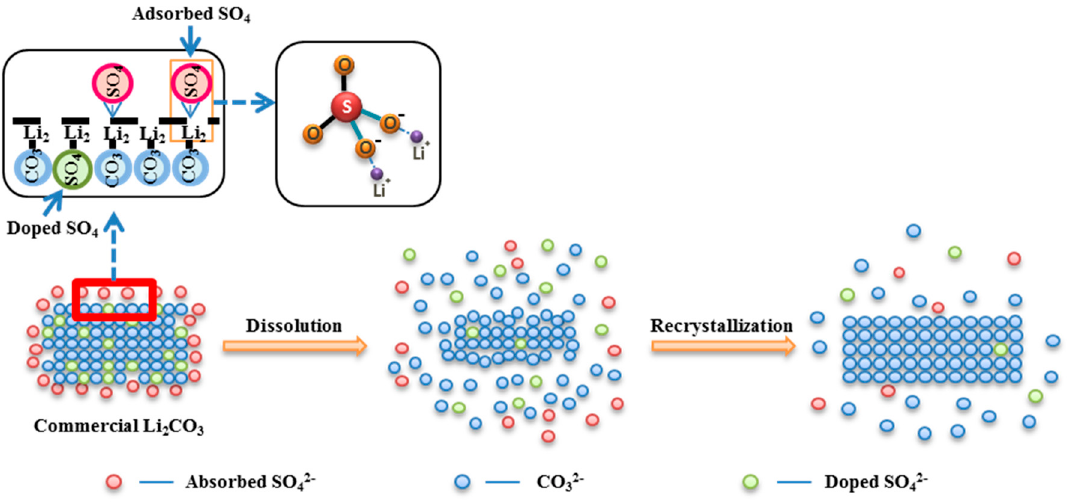
Figure 7. Schematic drawing for recrystallization of Li 2 CO 3.